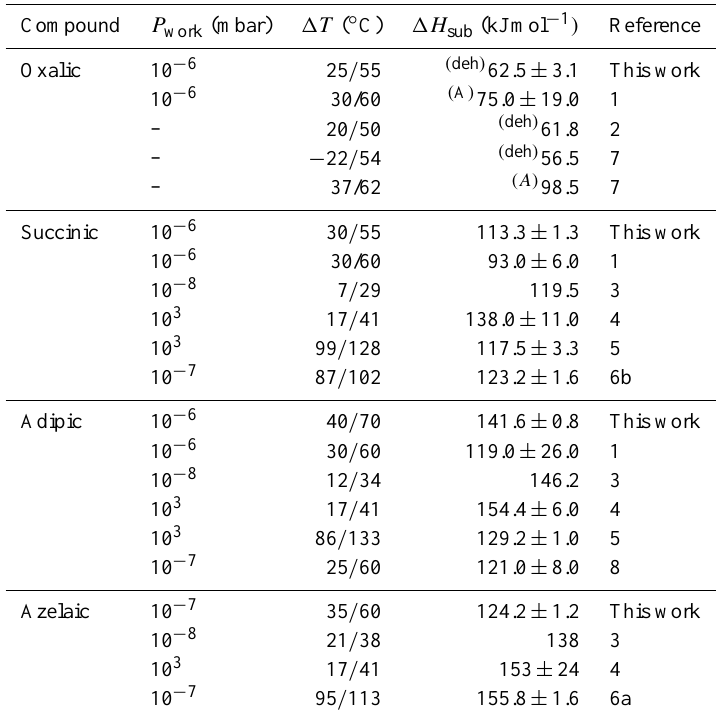
Table 4. Comparison of enthalpy of sublimation of dicarboxylic acids retrieved by different techniques (1 is Booth et al., 2009, 2 is Gra- novskaya 1948, 3 is Chattopadhyay and Ziemann 2007, 4 is Bilde et al., 2003, 5 is Davies and Thomas 1960, 6a is Ribeiro da Silva et al., 1999, 6b is Ribeiro da Silva et al., 2001,7 is de Wit et al., 1983, and 8 is Albyn, 2001). (cid:49)T ( ◦ C) is the temperature range used to calculate the enthalpy of sublimation. The enthalpy values and corresponding errors reported for this work have been calculated as the weighted average. The anhydrous (A) and dehydrate (deh) forms of the oxalic acid have been treated and the results for the enthalpy of sublimation have been